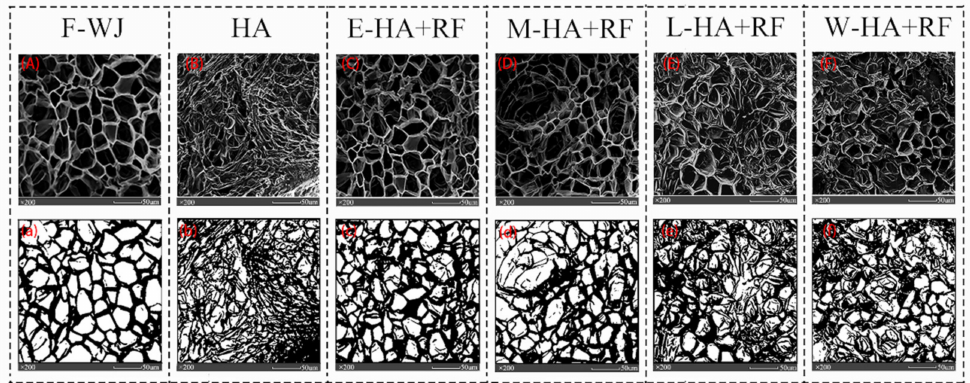
Figure 6. Microstructure and binary images of experiment samples. ( A ) microstructure of fresh jujube slice; ( B – F ) microstructure of jujube slices dried by different methods; ( a ) binary image of fresh jujube slice; ( b – f ) binary image of jujube slices dried by different